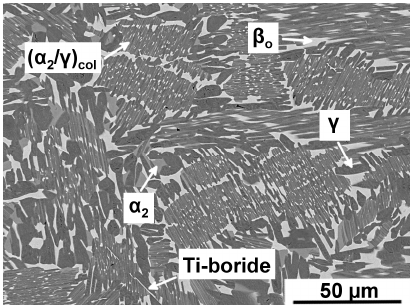
Figure 1. Cast and hot-isostatically pressed (cast/HIP) microstructure of a TNM alloy taken by scanning electron microscopy (SEM) in back-scattered electron (BSE) mode. The microstructure comprises of γ , α 2 , and β o phase of globular morphology as well as of α 2 / γ colonies with β o precipitates in between (secondary precipitates). The γ phase appears dark gray, the α 2 phase is light gray and the β o phase shows the brightest contrast. Moreover, a rod-shaped Ti-boride is visible at the bottom of this image.